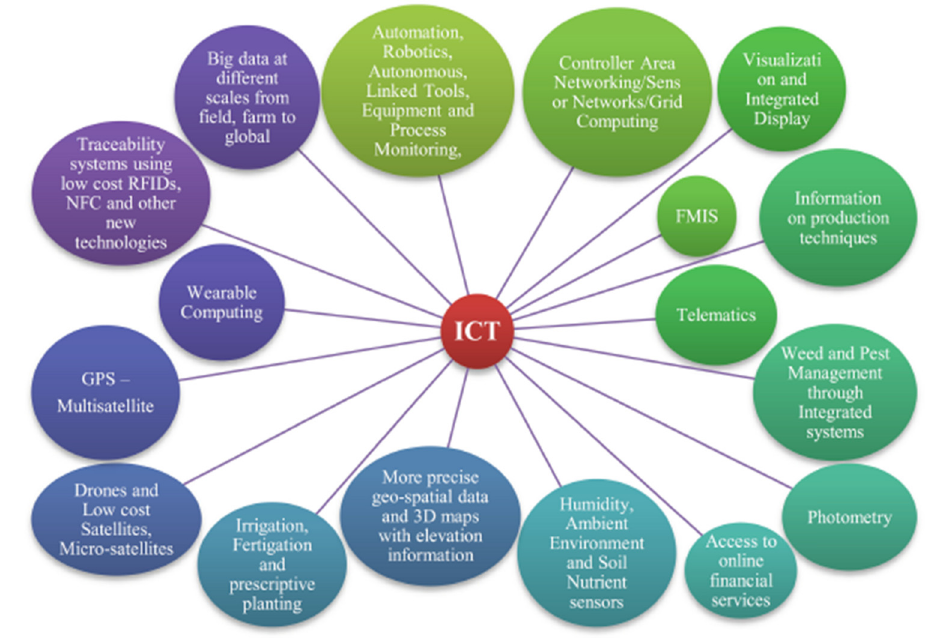
Figure 1: Impact of ICT in agriculture [ 8 ]